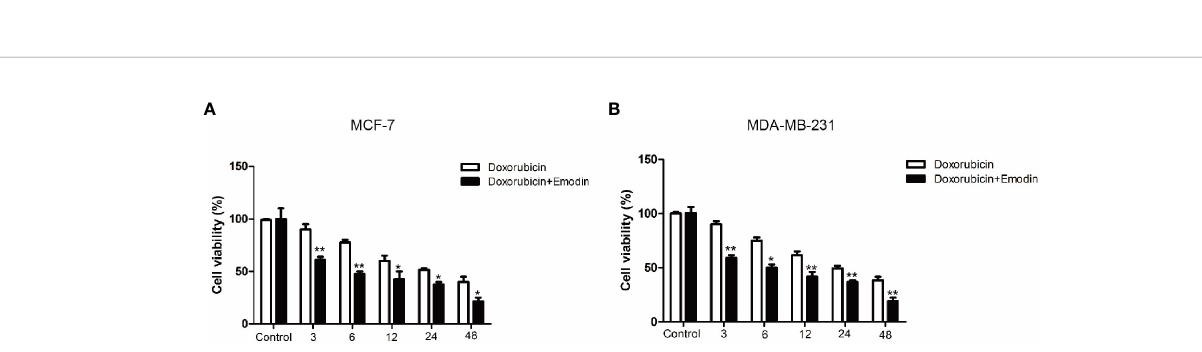
FIGURE 2 | Emodin inhibits tumor growth in vivo . (A) Tumor morphology. (B) The level of KI67 expression in tumor tissues. (C) The weight of tumor bodies. (D) The volume of tumor bodies. T test. * P < 0.05 vs Control. ** P < 0.01 vs Control.